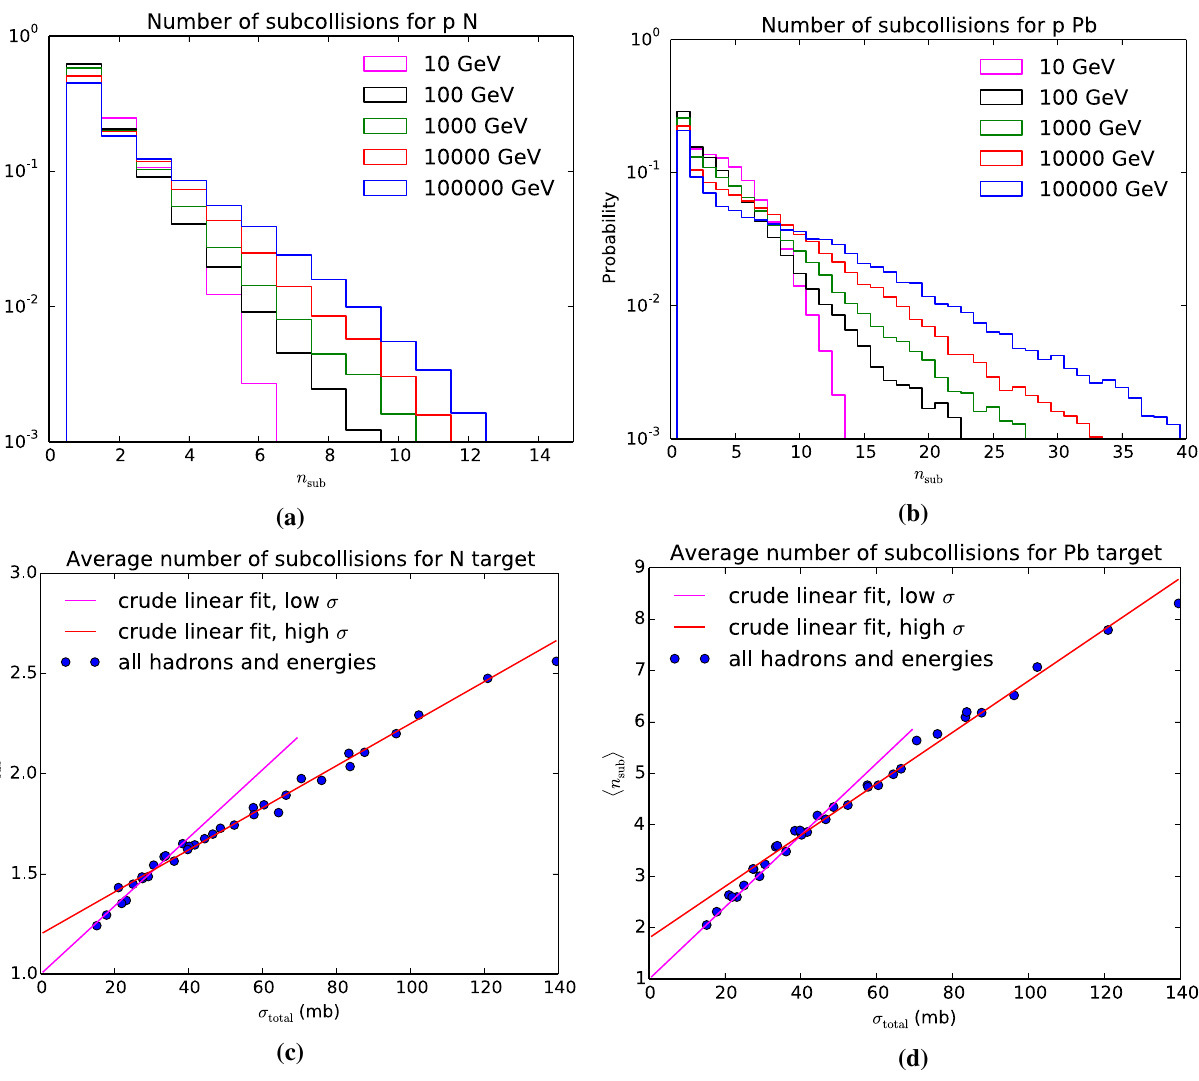
Fig. 9 Number of subcollisions in a proton–nitrogen and b proton–lead collisions at five different subcollision energies. The average subcollision number in c hadron–nitrogen and d hadron–lead as a function of the total cross section, with some fits, see text for